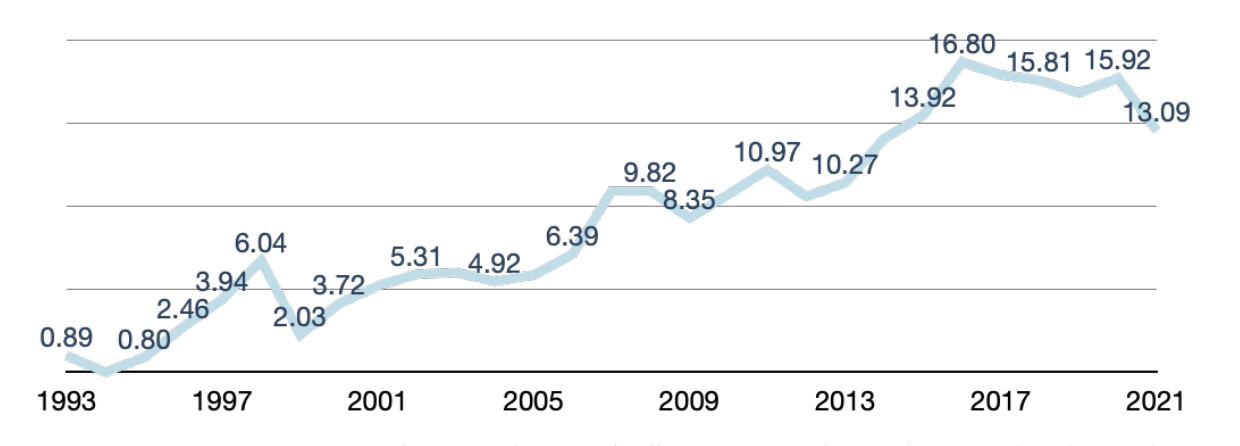
Figure 2. Changes in the ratio of palliative-associated research to annual total research in Taiwan from 1993 to 2021 (presented by basis point).